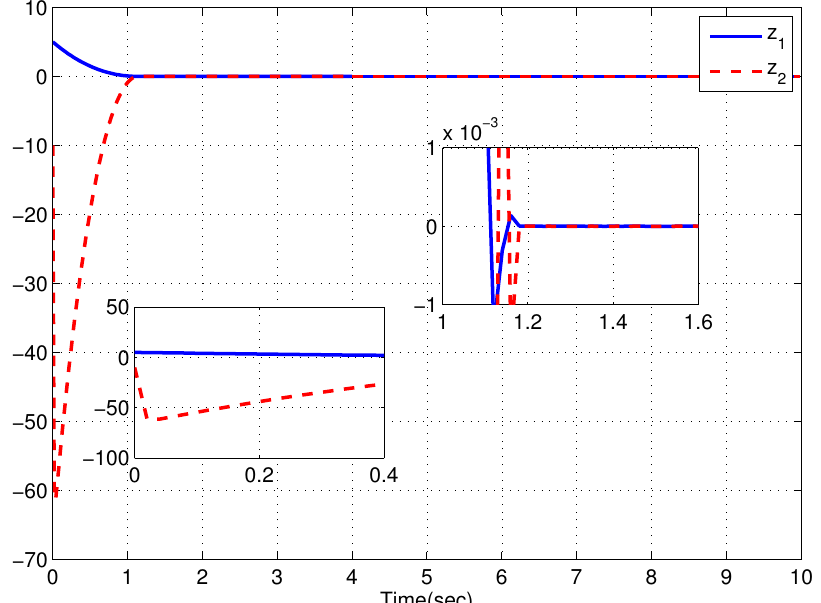
Figure 4. The state responses of the CLS with initial condition ( z 1 ( 0 ) , z 2 ( 0 )) = ( 5, − 10 ) .